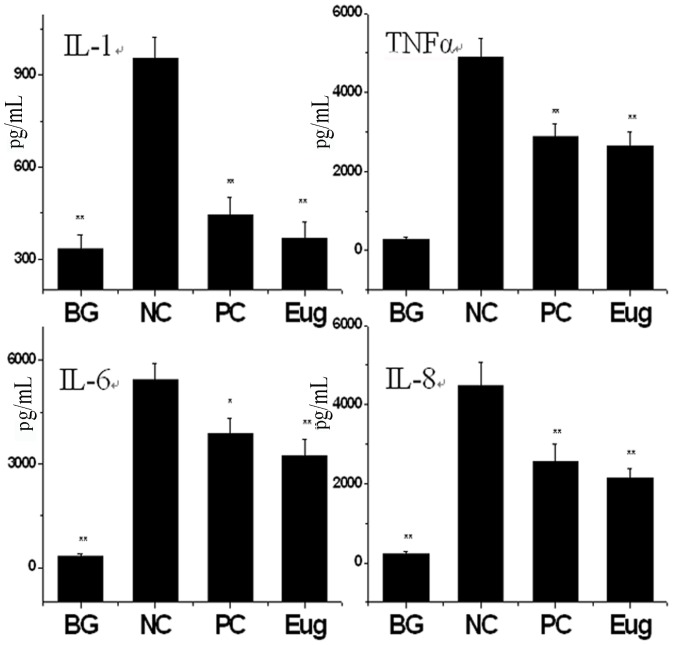
Eugenol inhibited the release of cytokines induced by IAV (A/ShanTou/169/06 (H1N1)).The treatments of untreated, virus only, ribavirin and Eug groups were same with those in Figure 6. The infection time was 24 h, MOI = 0.001. Data shown were the mean ± SD of three independent experiments. *P<0.05, **P<0.01 vs the negative control group (virus only).